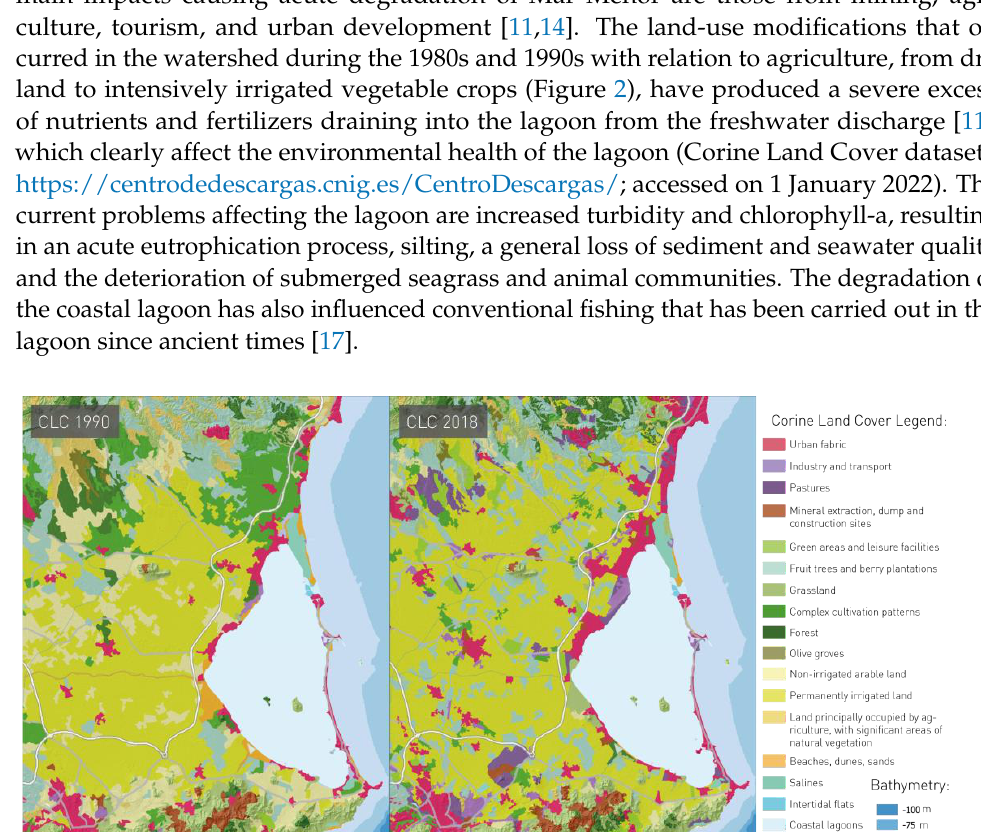
Figure 2. Land cover classification for the Mar Menor lagoon and its surroundings according to Corine Land Cover datasets (https://centrodedescargas.cnig.es/CentroDescargas/; accessed on 1 January 2022) for 1990 and 2018.